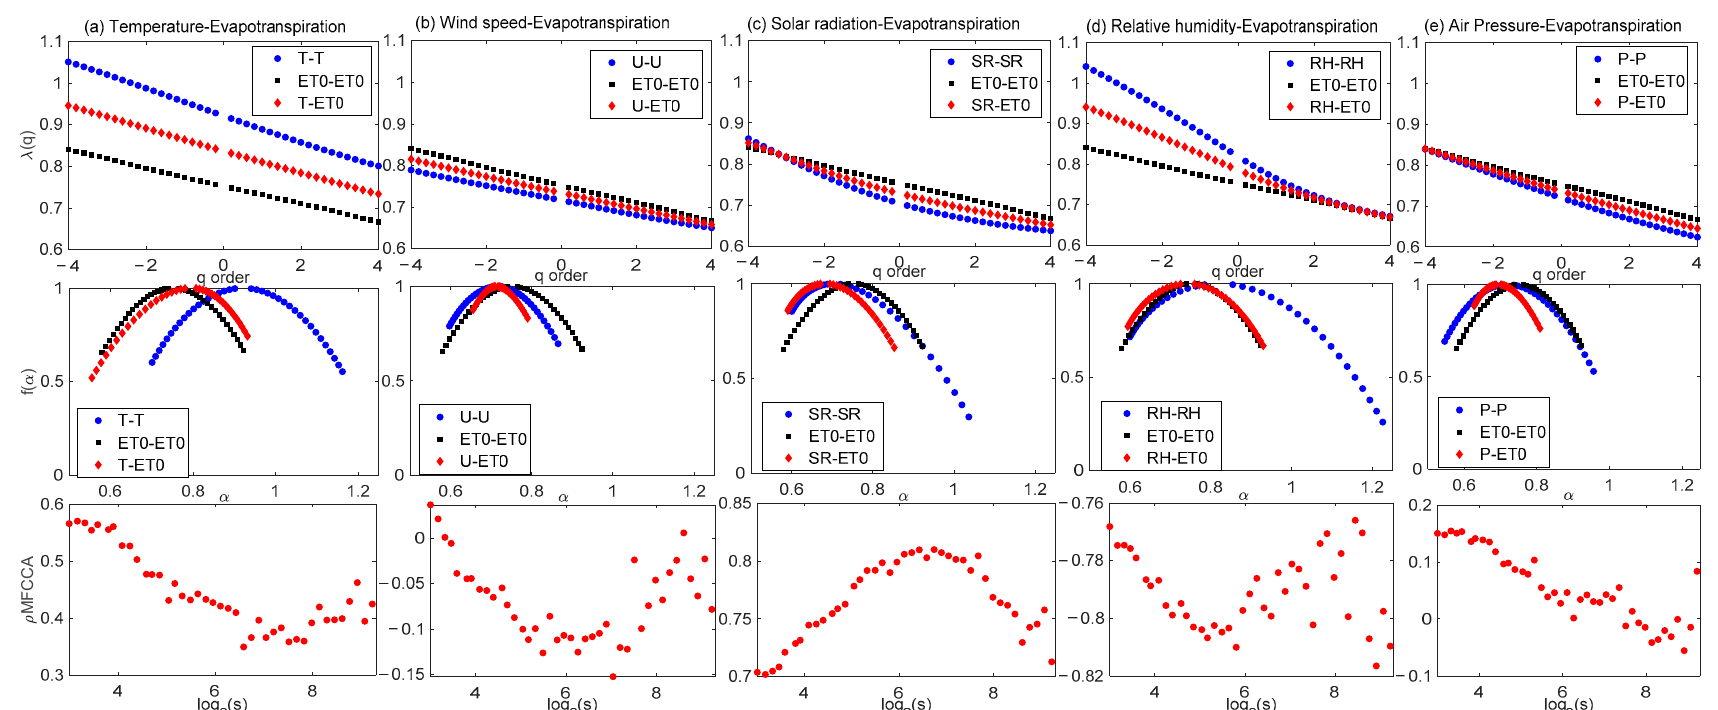
Figure 8. GHE plots (upper panels), multifractal spectra (middle panels) and cross-correlation plots (lower panels) obtained by MFCCA of different links at San Diego station: ( a ) T-ET0; ( b ) U-ET0; ( c ) SR-ET0; ( d ) RH-ET0; ( e ) P-ET0.